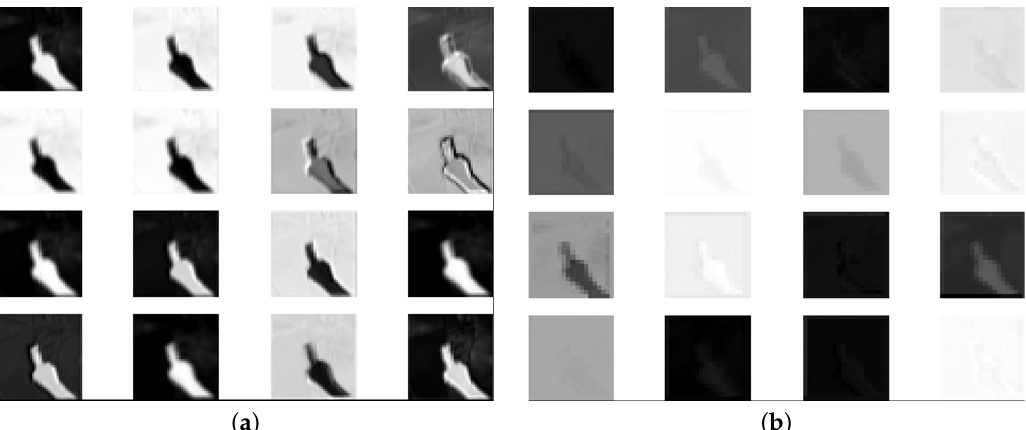
Figure 3. Feature maps from different bottleneck layers: ( a ) bottleneck layer No. 9; and ( b ) bottleneck layer No.